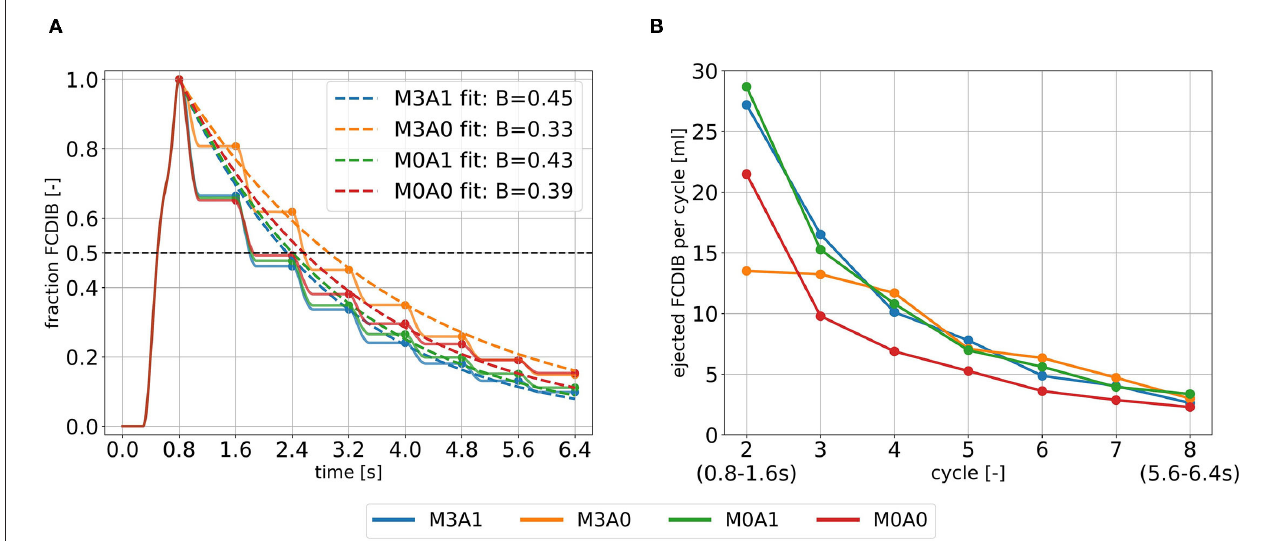
FIGURE 9 | Intraventricular washout of FCDIB until the end of cycle eight (A) and the respective ejected fractions of FCDIB per cycle (B) . To perform the exponential fit, the FCDIB fractions at the end of each cycle were used [marked as dots in (A) ].